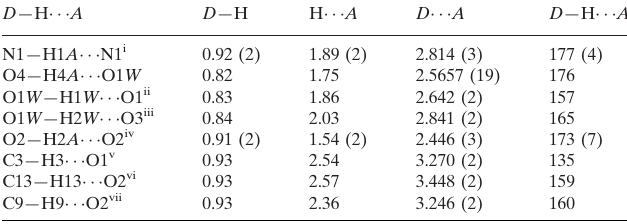
Hydrogen-bond geometry (A˚ , (cid:4)